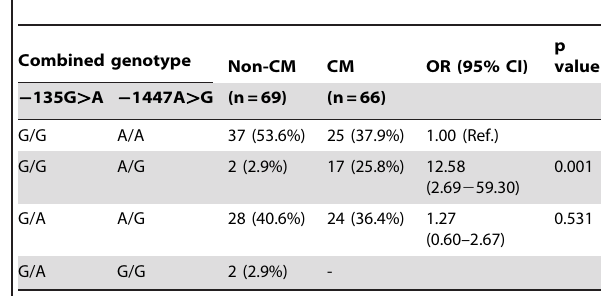
Table 3. Combined genotype frequencies of CXCL10 polymorphisms in patients with cerebral malaria and non- cerebral malaria.